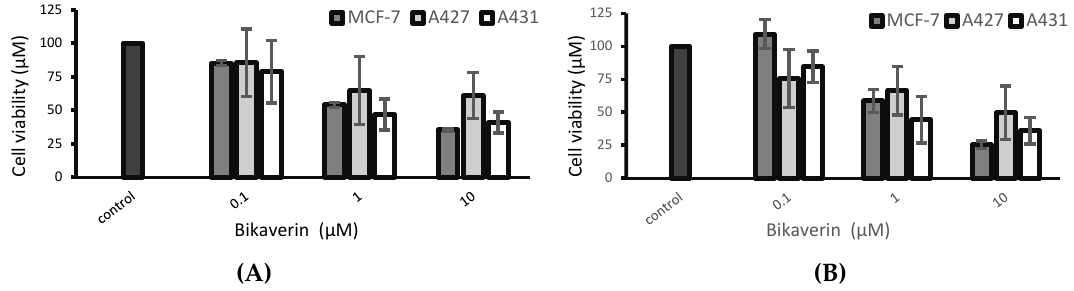
Figure 3. Cell viability of MCF7, A427 and A431 cells after ( A ) 24 h and ( B ) 48 h treatment